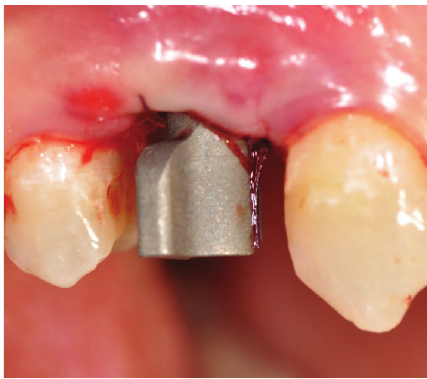
Figure 8: Screwing of the scan abutment, needful to take a scanning with MHT 3D Progress intraoral scanner. Vestibular